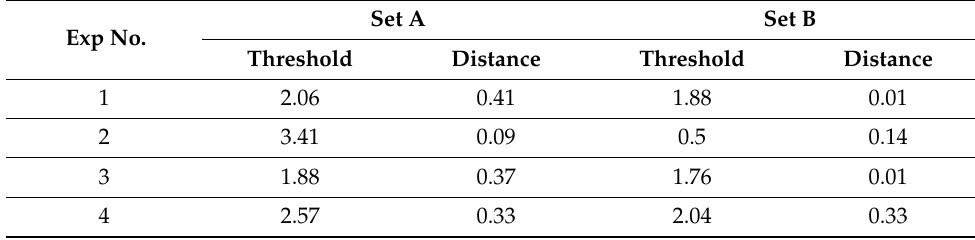
Table 2. Log thresholds and distances when integrating experiments for each set.